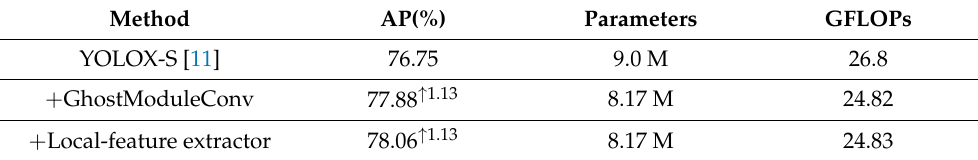
Table 2. Comparison of model accuracy before and after adding